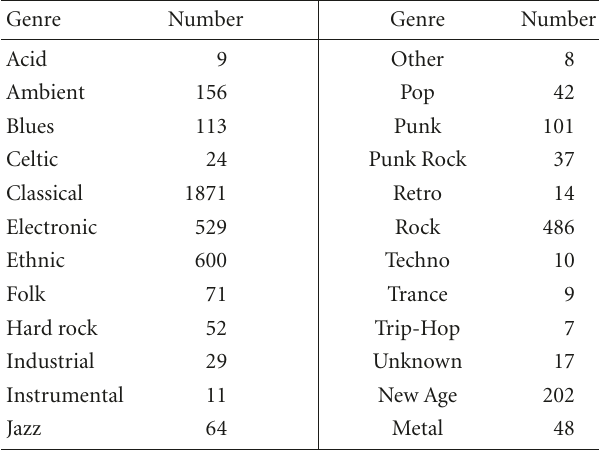
Table 1: Genre distribution for Magnatune data set.